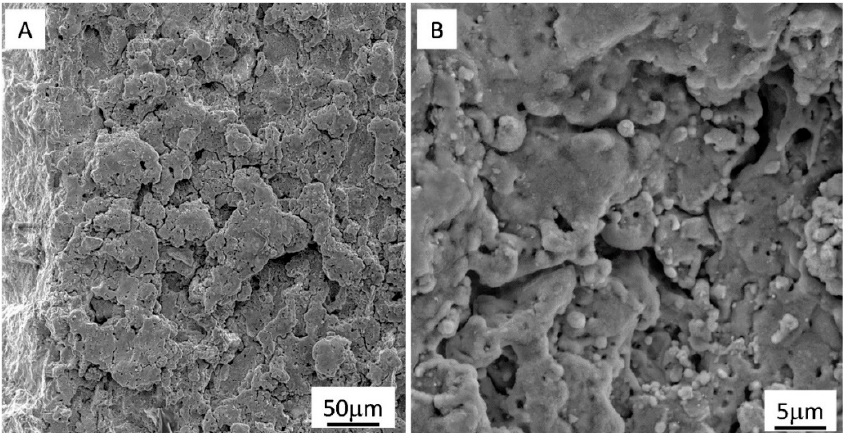
Figure 7. Topography of WEDM surface of α - β 20T ceramic at different magnifications.